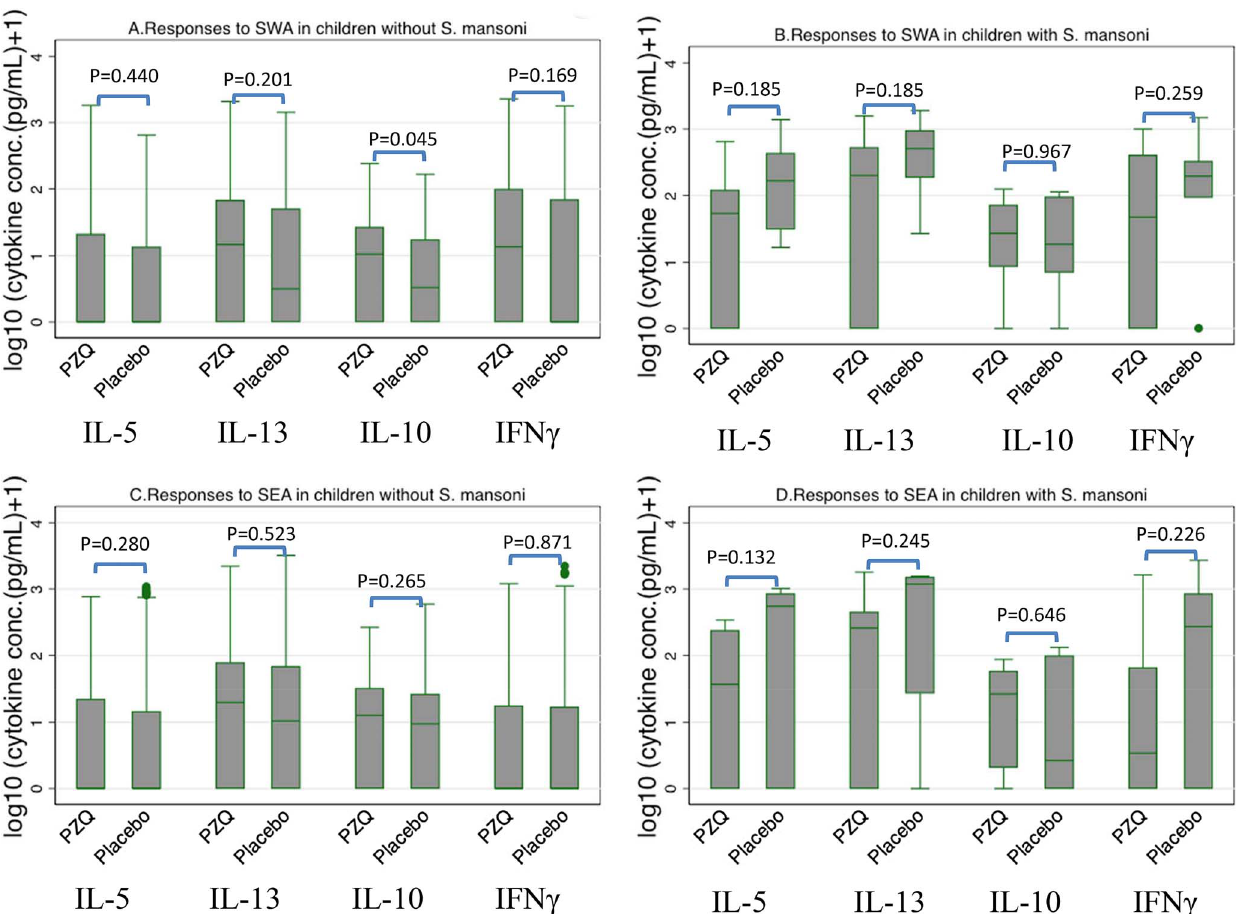
Figure 2. Effect of praziquantel treatment during pregnancy on cytokine responses to SWA or SEA among the children infected or not infected with Smansoni at age 5 years. Infected children, praziquantel group (PZQ) n=14, placebo n=6; uninfected children, PZQ n=178, placebo n=206. Shown are levels of cytokine production in response to SWA (A & B) or SEA (C &D).